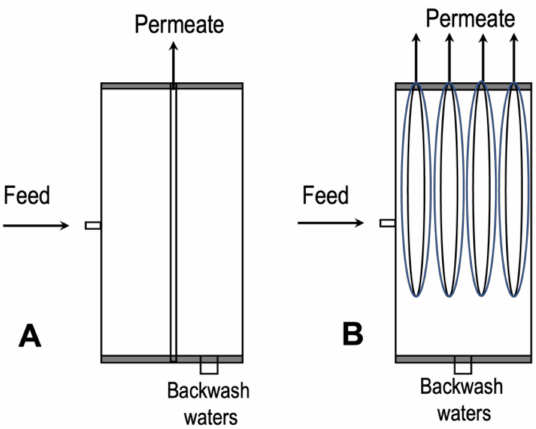
Figure 2. Sectional drawings and pictures of the filtration modules unit ( A ) and ( B )